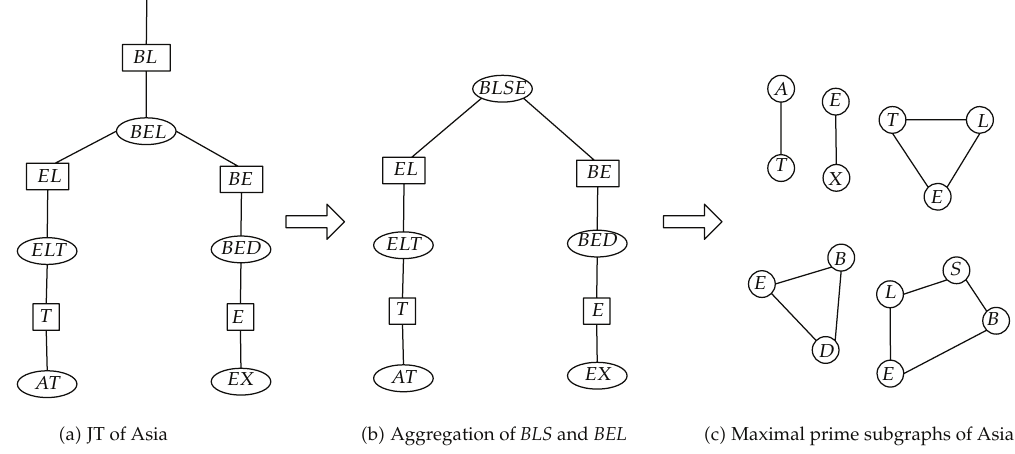
Figure 2: The process of decomposing the Asia moral graph into its maximal prime